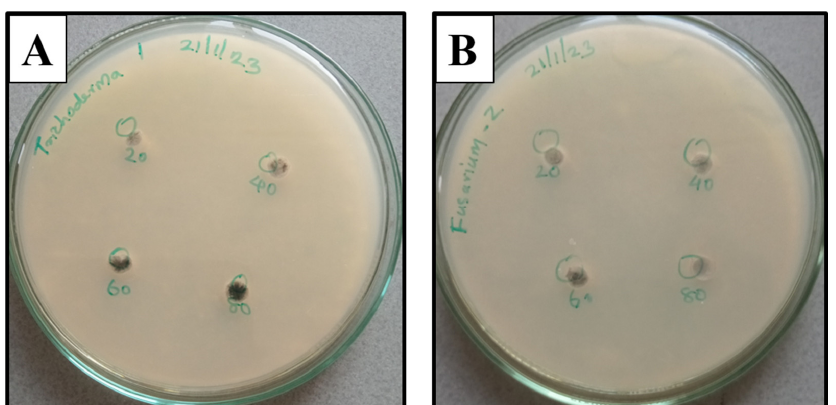
Figure 7. Antifungal activity of 70wt% of CuO loaded g-C 3 N 4 nanocomposite solution with the var- ious concentrations of 20, 40, 60, and 80 μL ( A ), Trichoderma viride , and ( B ) Fusarium